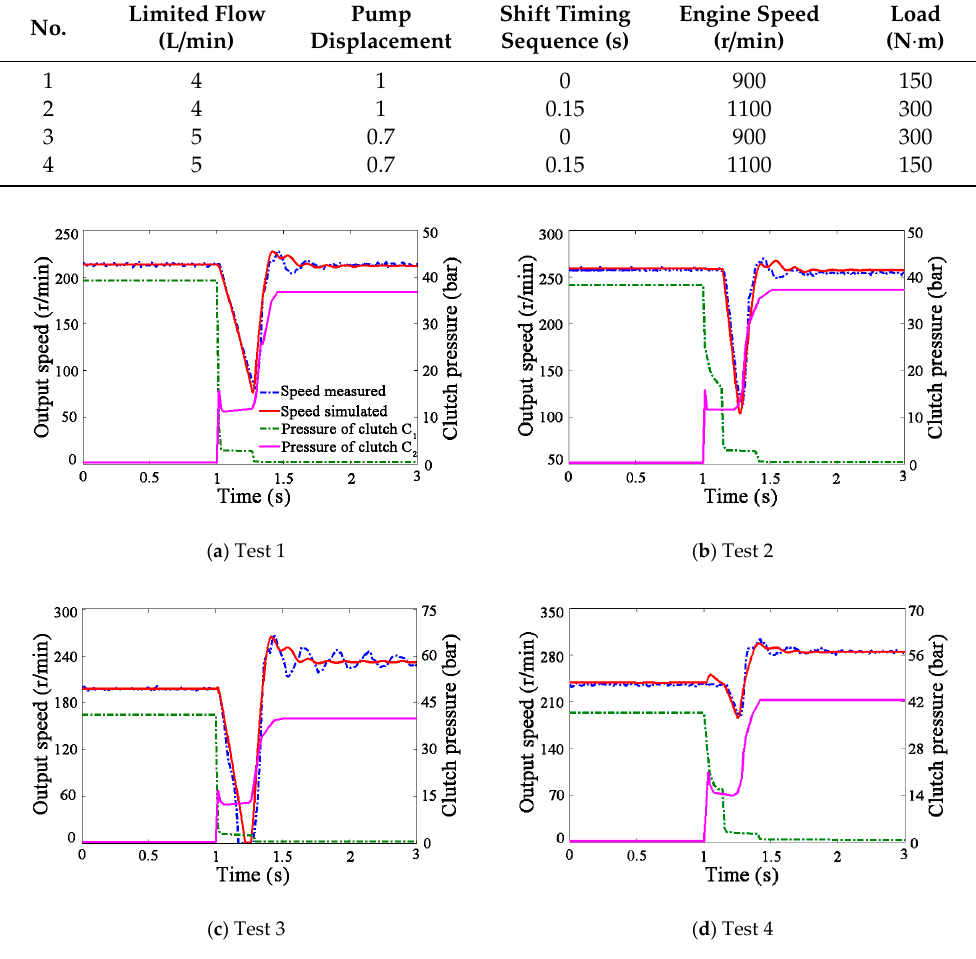
Figure 10. Test verification of the transmission model.